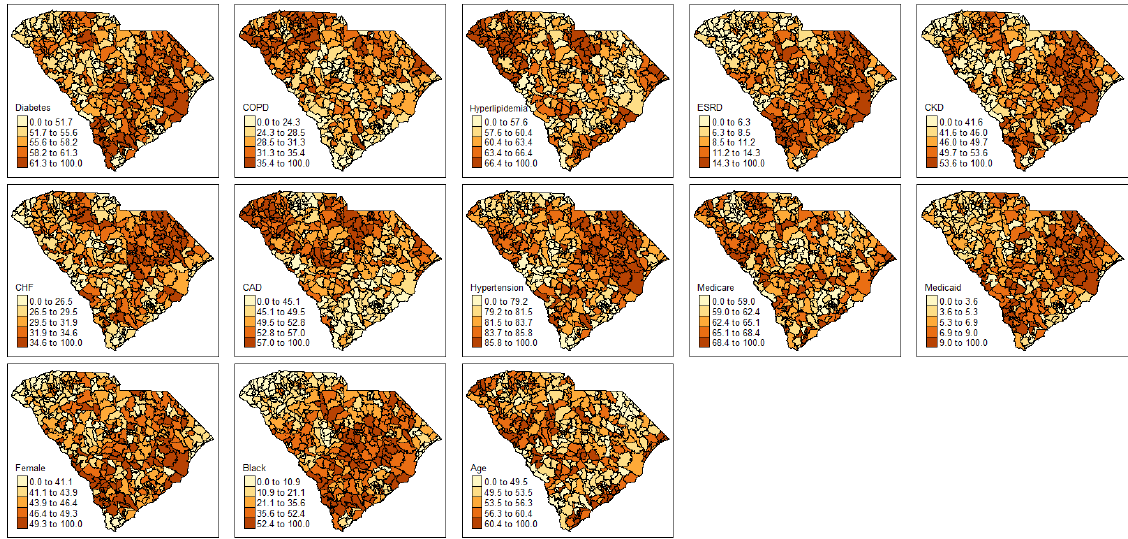
Figure 2. Choropleth maps of percent of comorbid conditions at the ZCTA level.